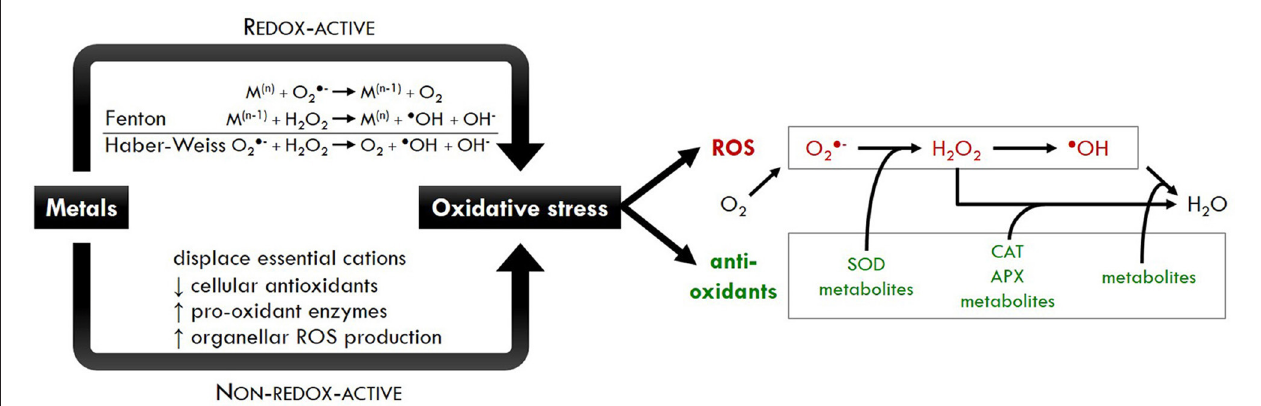
FIGURE 1 | Schematic overview of metal-induced oxidative stress. Redox-active metals such as Cu and Fe can participate in the Fenton and Haber-Weiss reactions, finally leading to the formation of highly toxic • OH radicals from H 2 O 2 . On the other hand, non-redox-active metals such as Cd and Zn can only indirectly contribute to ROS production by (1) displacing essential cations, (2) depleting cellular antioxidants, (3) increasing the activity of ROS producing enzymes and/or (4) enhancing ROS production in organelles. The net result for both classes of metals is the induction of oxidative stress, an imbalance between ROS and antioxidants in favor of the former. Abbreviations: APX, ascorbate peroxidase; CAT, catalase; H 2 O 2 , hydrogen peroxide; M (n) , oxidized redox-active metal; M (n − 1) , reduced redox-active metal; O •− 2 , superoxide; OH − , hydroxide ion; • OH, hydroxyl radical; SOD, superoxide